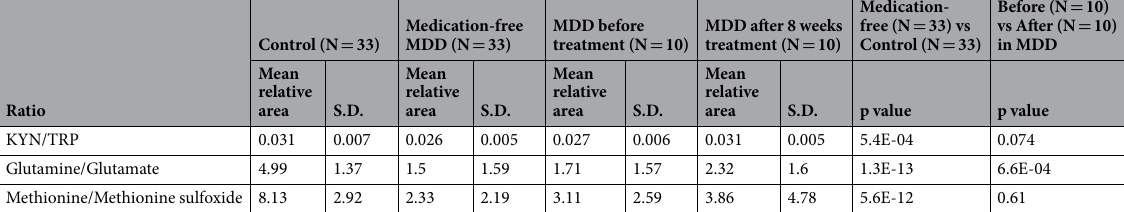
Table 3. Ratios of metabolites in control subjects and MDD patients before and after antidepressant treatment.